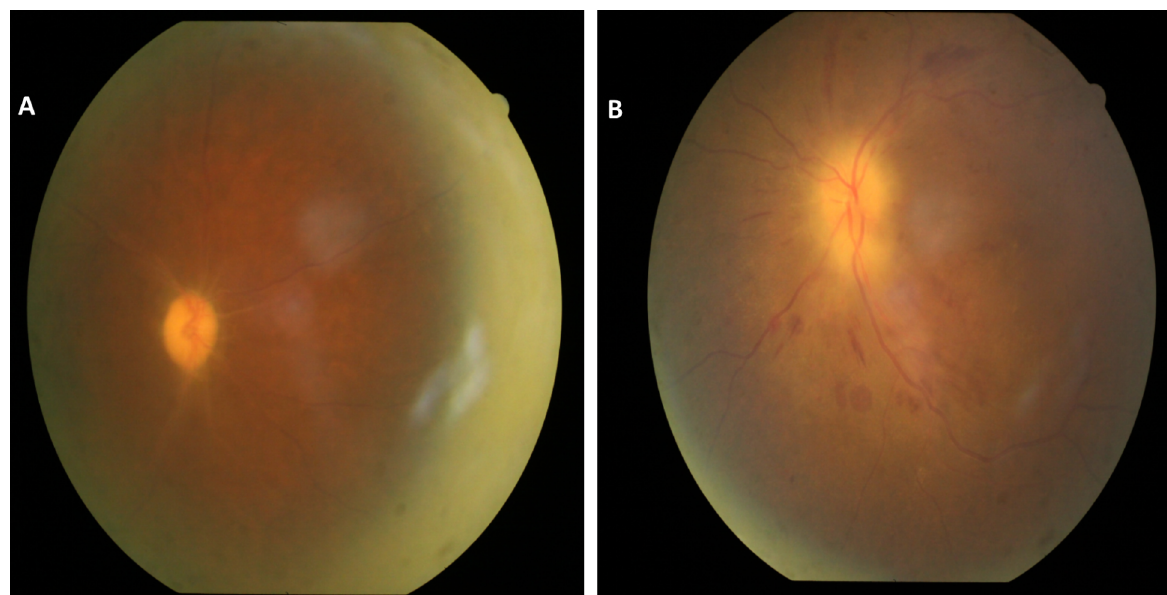
Figure 1: Fundus picture of RE showing optic disc pallor with arteriolar attenuation (A). Fundus picture of LE showing pallid disc edema, flame-shaped retinal hemorrhages in peri-papillary region and attenuation of retinal arterioles (B). retinal arterioles, and arterio-venous crossing changes without any background diabetic retinopathy (Figure